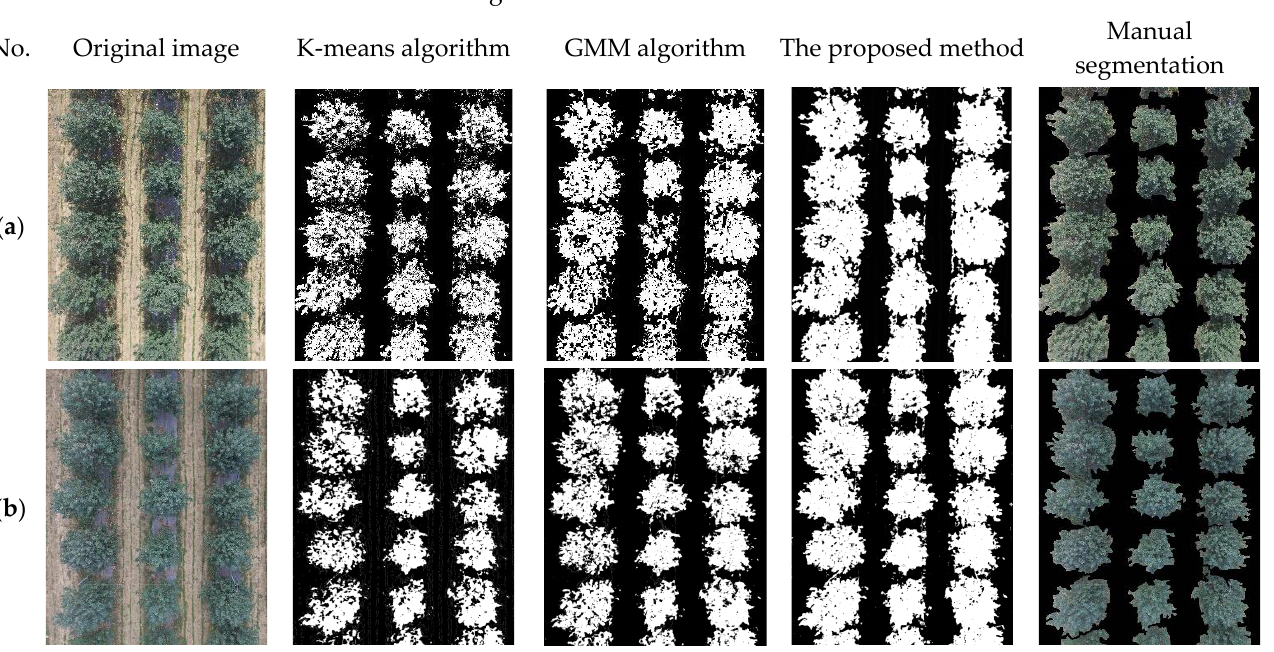
Figure 9. Comparison of the different segmentation results: ( a ) sunny day with direct solar illumi- nation; and ( b ) cloudy day without direct solar illumination.